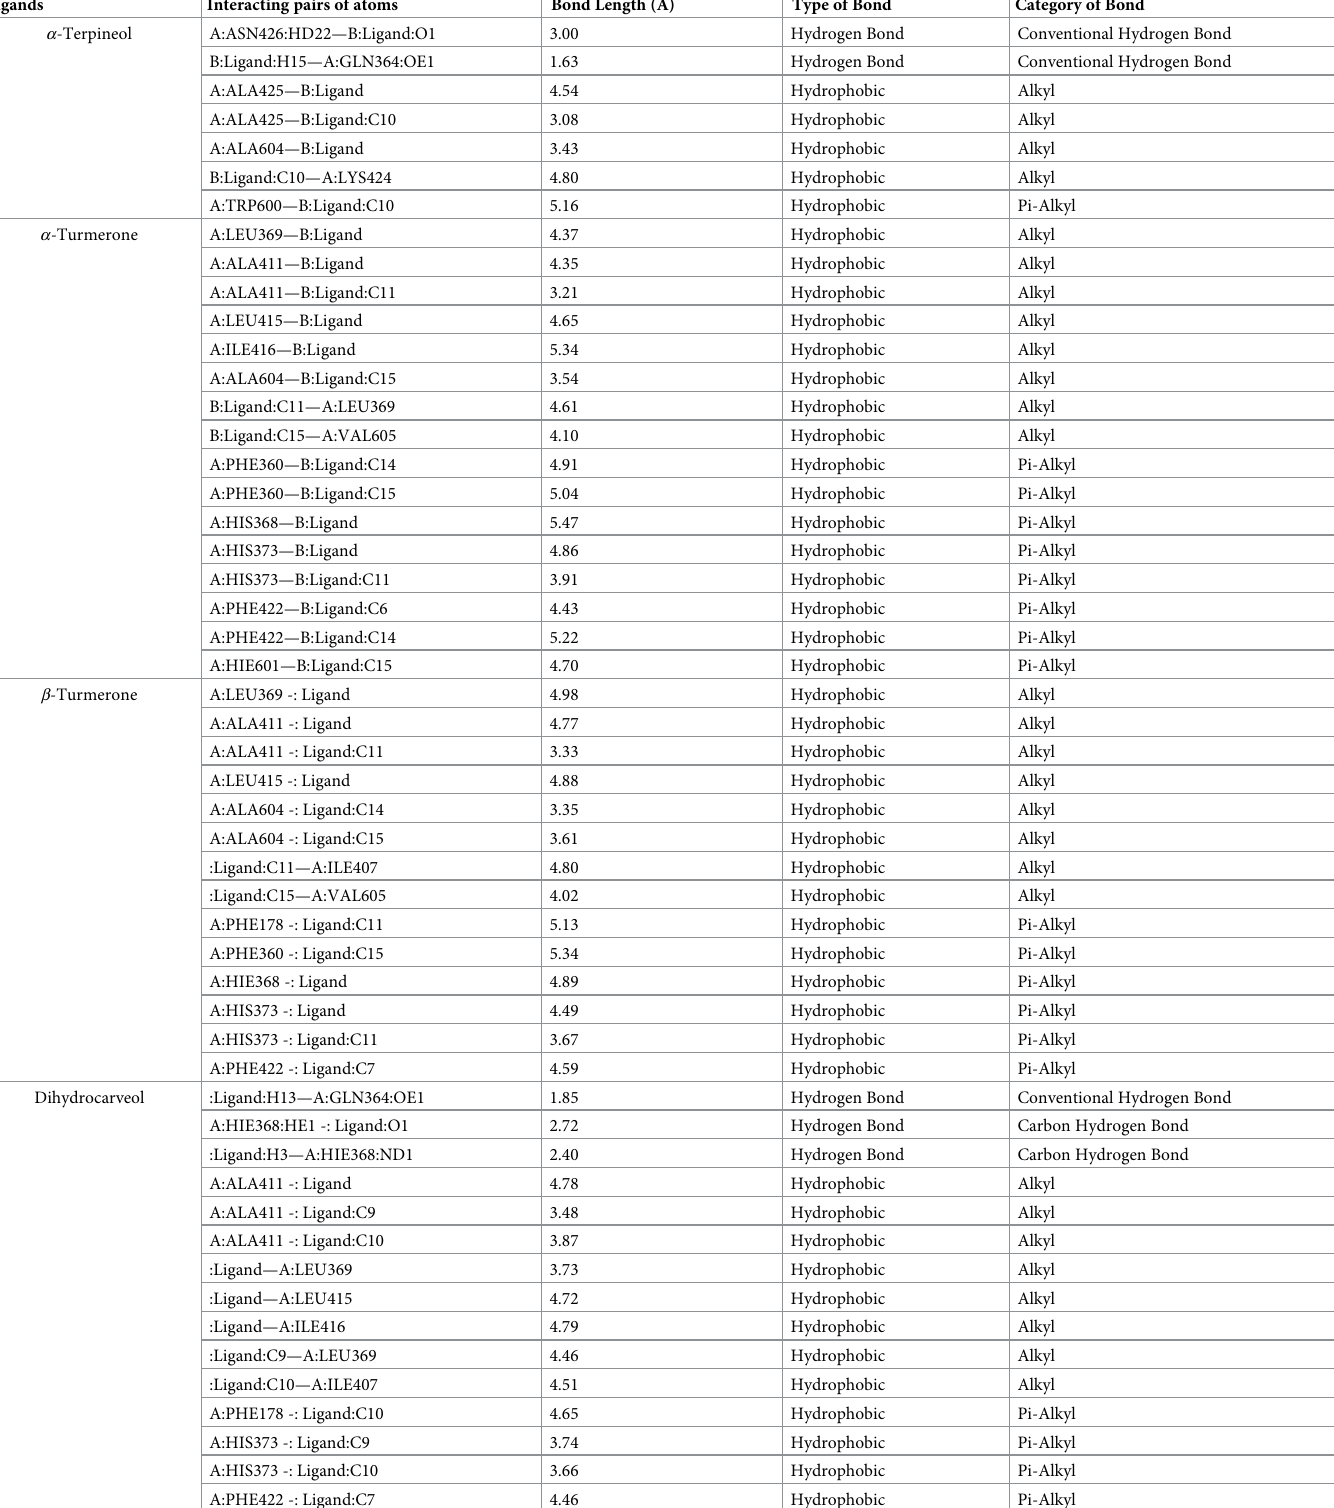
Table 2. Inter-molecular contact analysis portraying the different types of non-bonded contact between the top four compounds with target protein 5-LOX ana- lyzed using BIOVIA DSV. Ligands Interacting pairs of atoms Bond Length ( Å